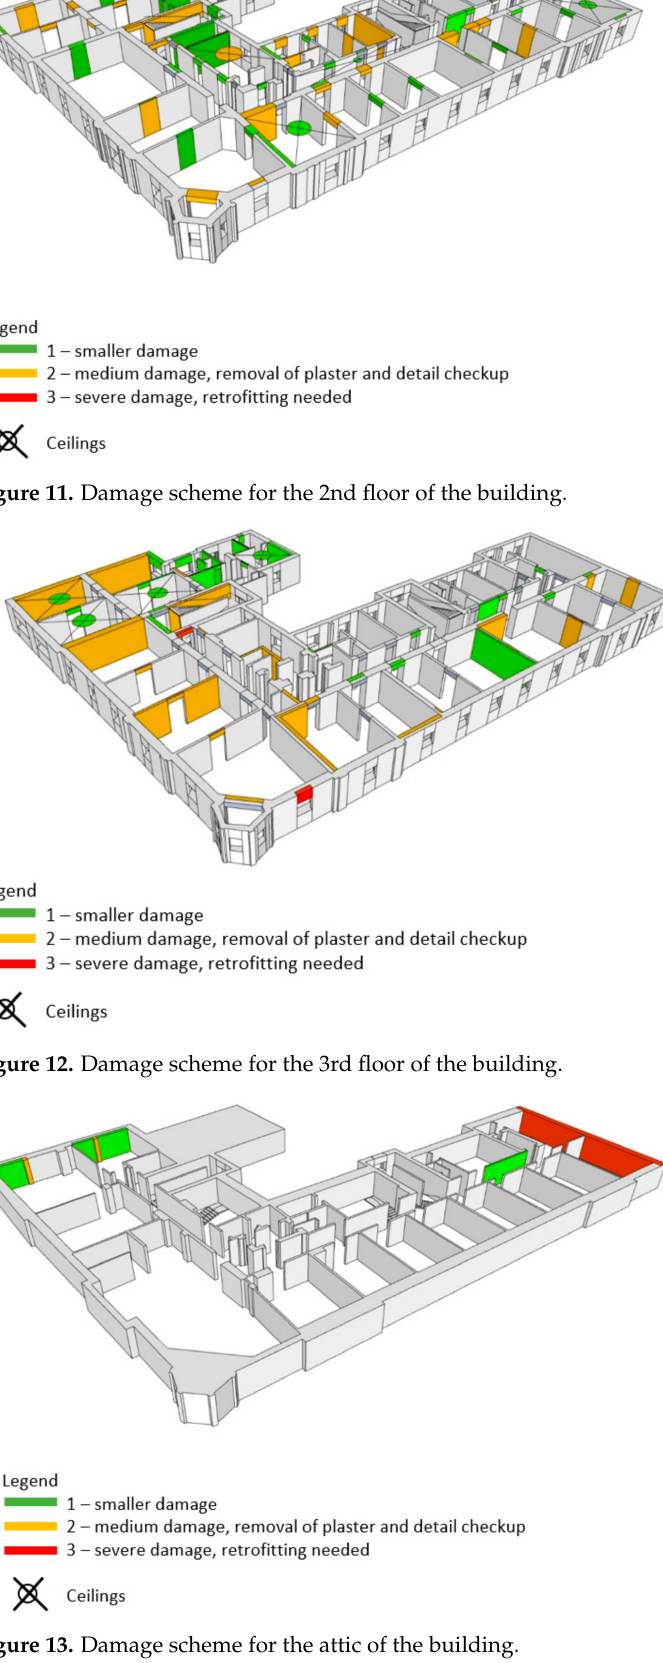
Figure 13. Damage scheme for the attic of the